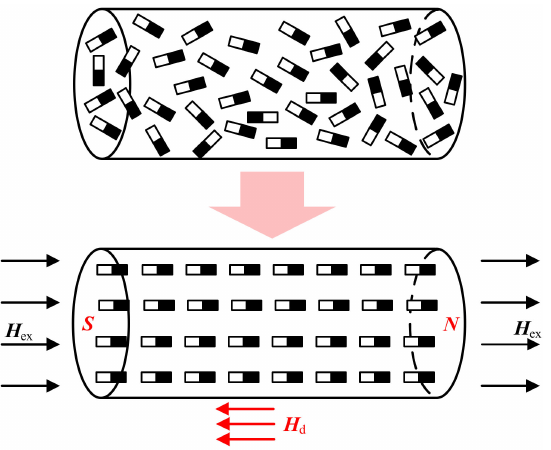
Figure 11. Schematic diagram of the magnetization principle of the magnetic core.